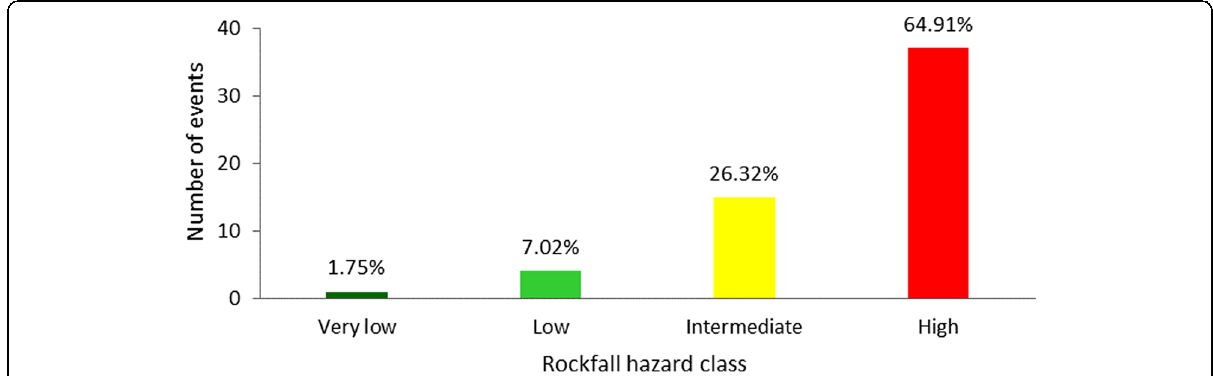
Fig. 12 Percentage of rockfall occurred in each rockfall hazard